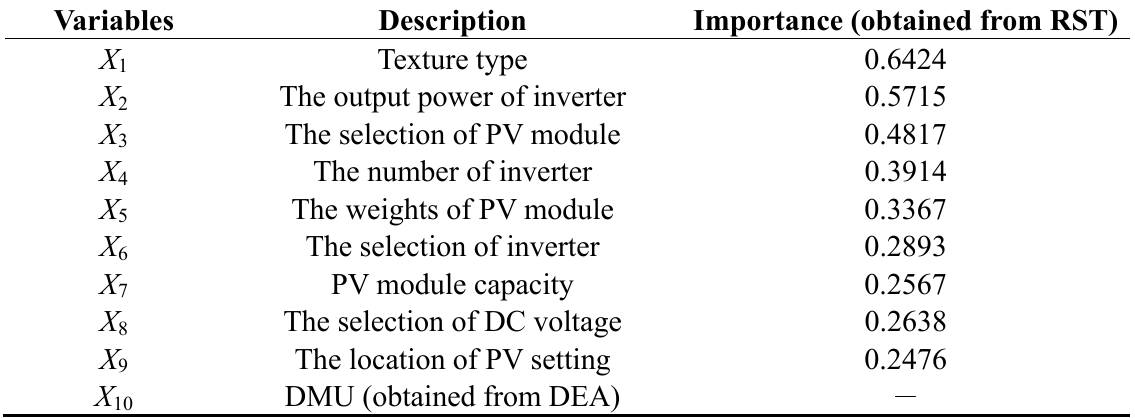
Table 2. Selected significant variables from RST and DMU variable from